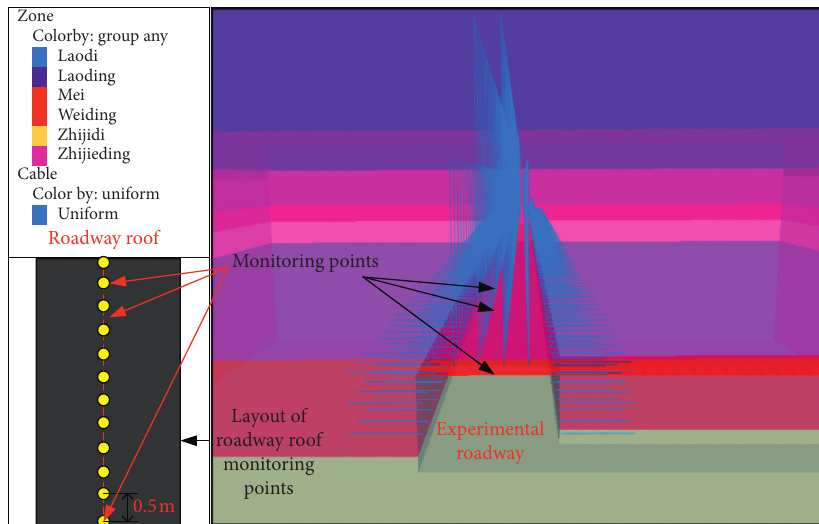
Figure 7: Orthogonal experimental model. Table 3: Variance analysis of convergences of surrounding rock surface of the roadway roof.